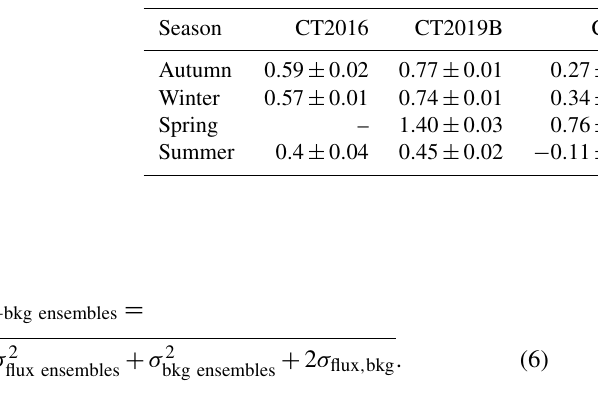
Table 2. Systematic bias between global 4D CO 2 fields and AirCore profiles above 8km. Across-model mean and standard deviation is weighted with the pressure weighting function and OCO-2 averaging kernel. All values are in parts per million. The location of AirCore profiles is shown as orange squares in Fig.